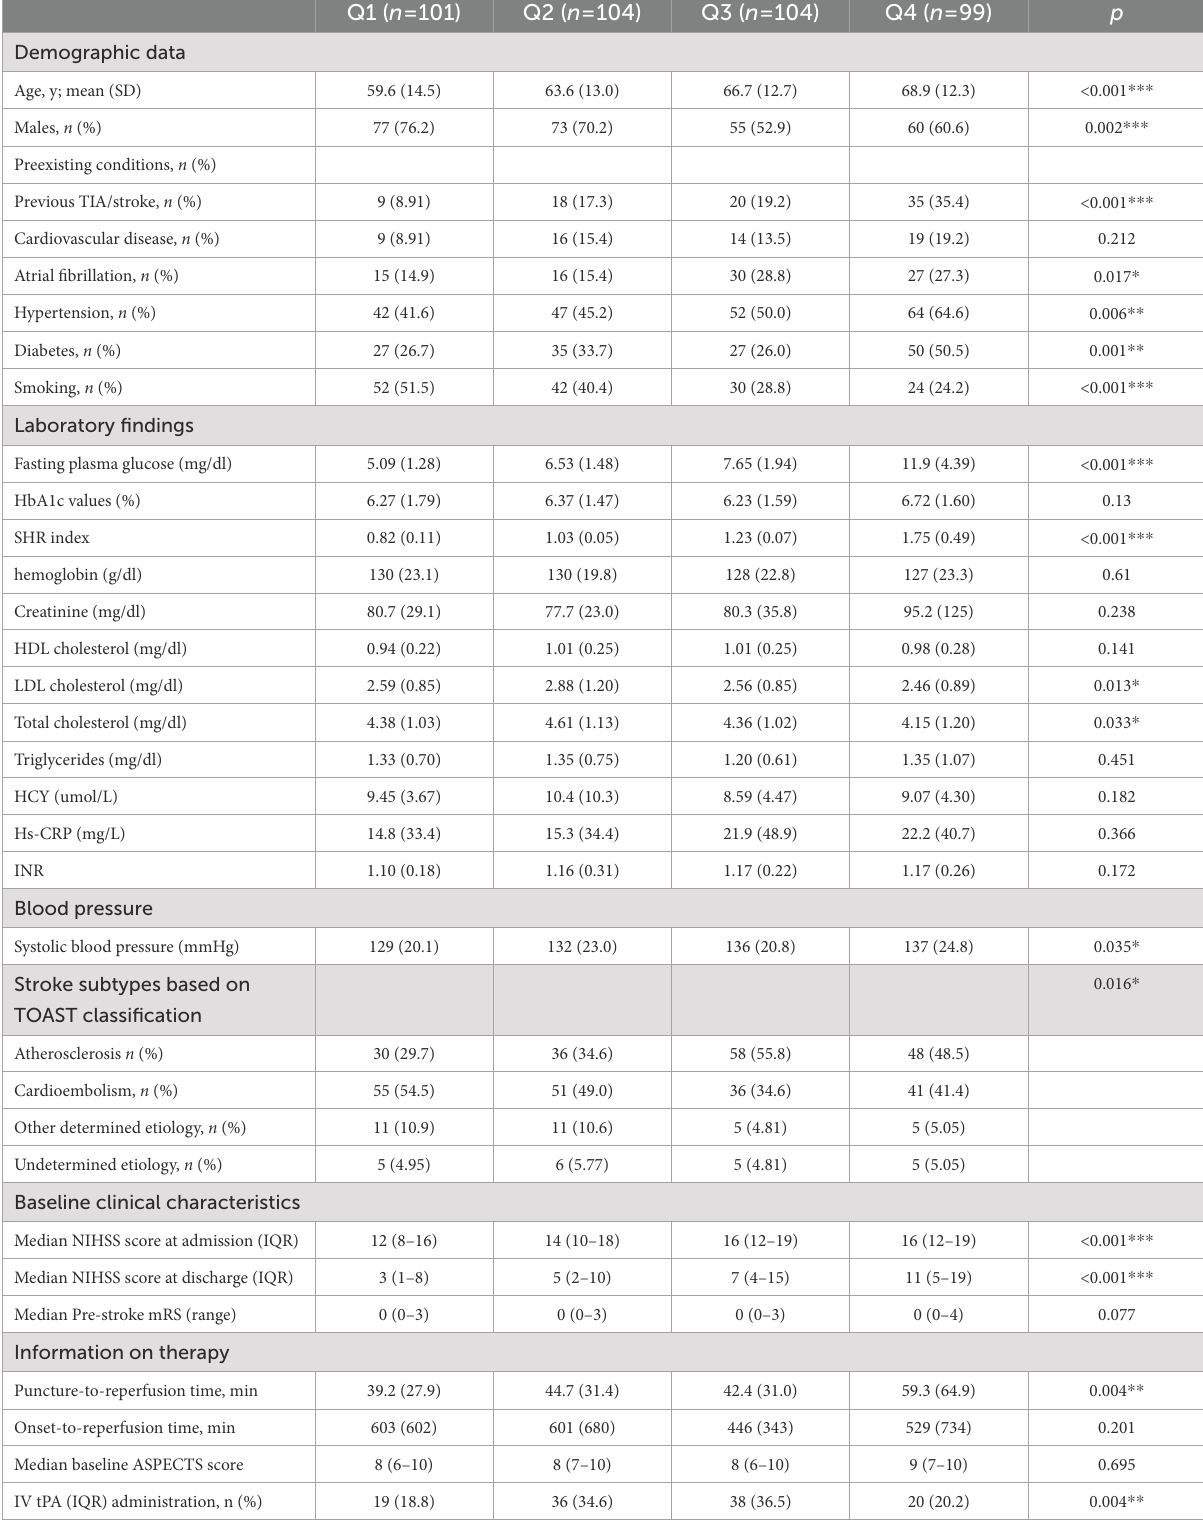
TABLE 1 Baseline characteristics of the patients by quartile of FPG/HbA1c ratio. Q1 ( n =